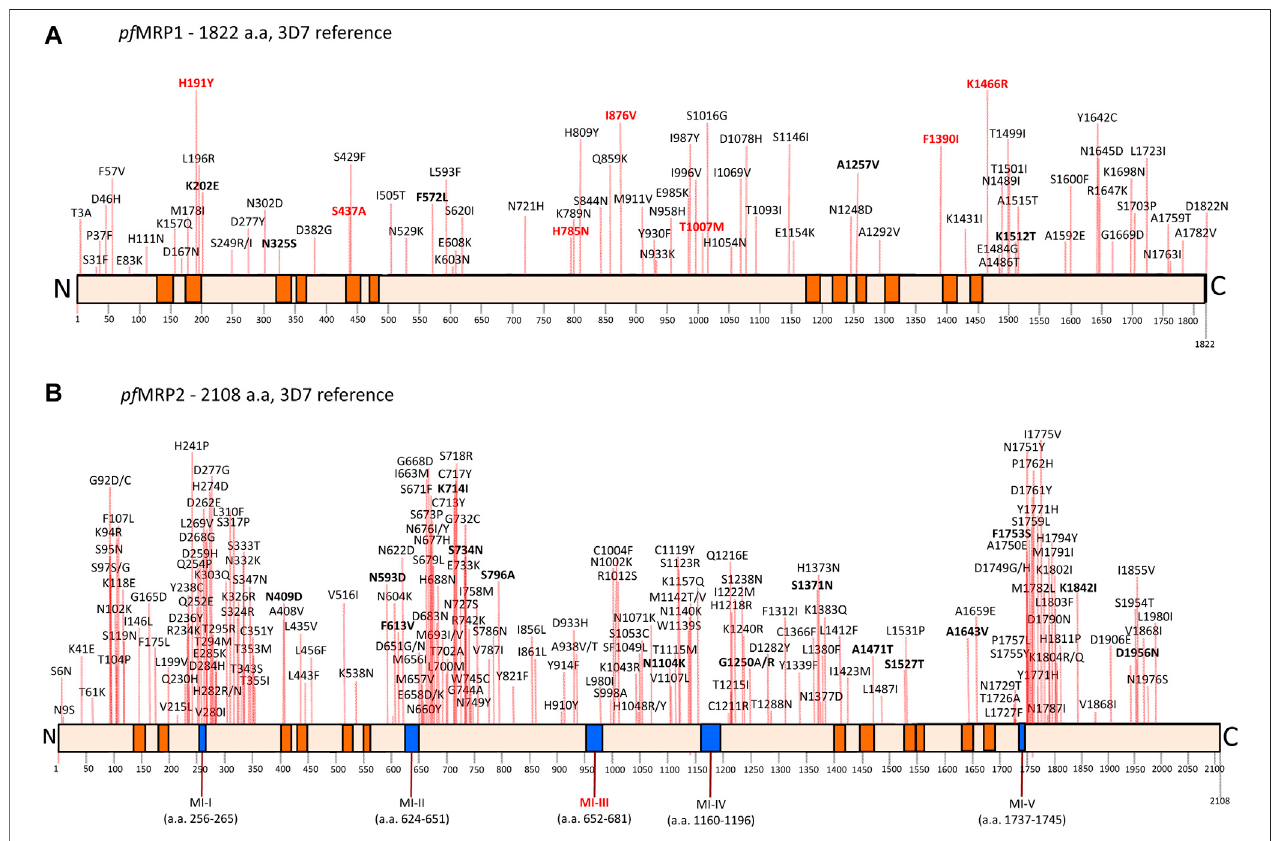
FIGURE 1 | Compilation of non-synonymous SNPs in pf MRP1 (A) and pf MRP2 (B) . This was based on MalariaGen and the article list of bibliographic references. SNPs in bold correspond to alleles with frequencies above 1%, according to the MalariaGen Community Project. In bold red, SNPs that have been reported as associated with parasite drug response (see main text and Table 1 ). Boxes in orange denote transmembrane domains (Dahlstrom et al., 2009; Veiga et al., 2014). Blue boxes in the pf MRP2 fi gure correspond to micro-indel (MI) regions comprising variable tandem repeat regions (Veiga et al., 2014). MI-III has been observed to be associated with lumefantrine response (Okombo et al., 2013), being as such also marked in bold red. To note the trend for SNP hotspots in pf MRP2.